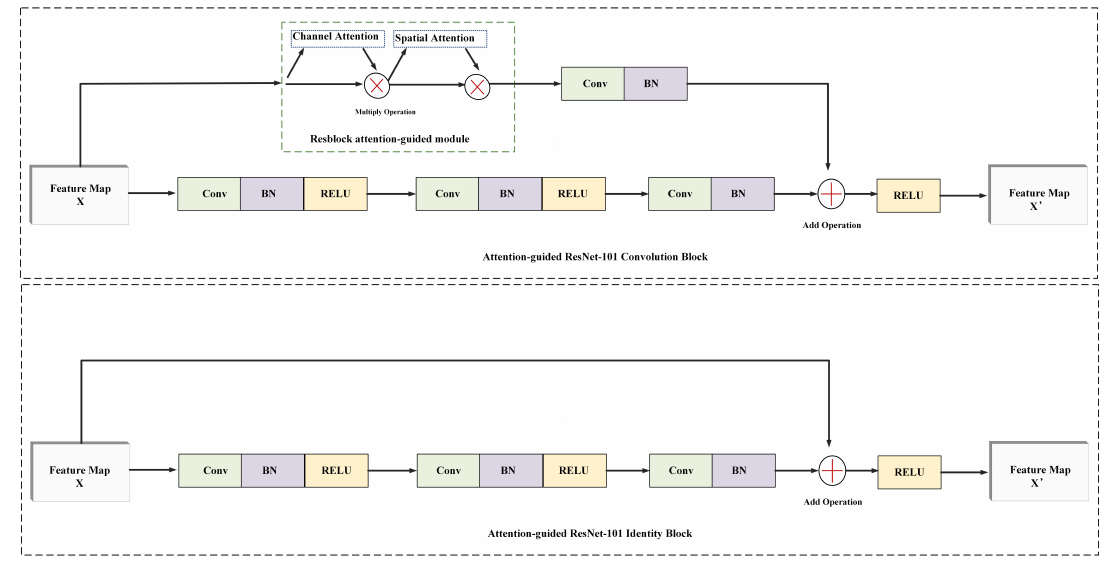
Figure 3. An example of Resblock attention-guided